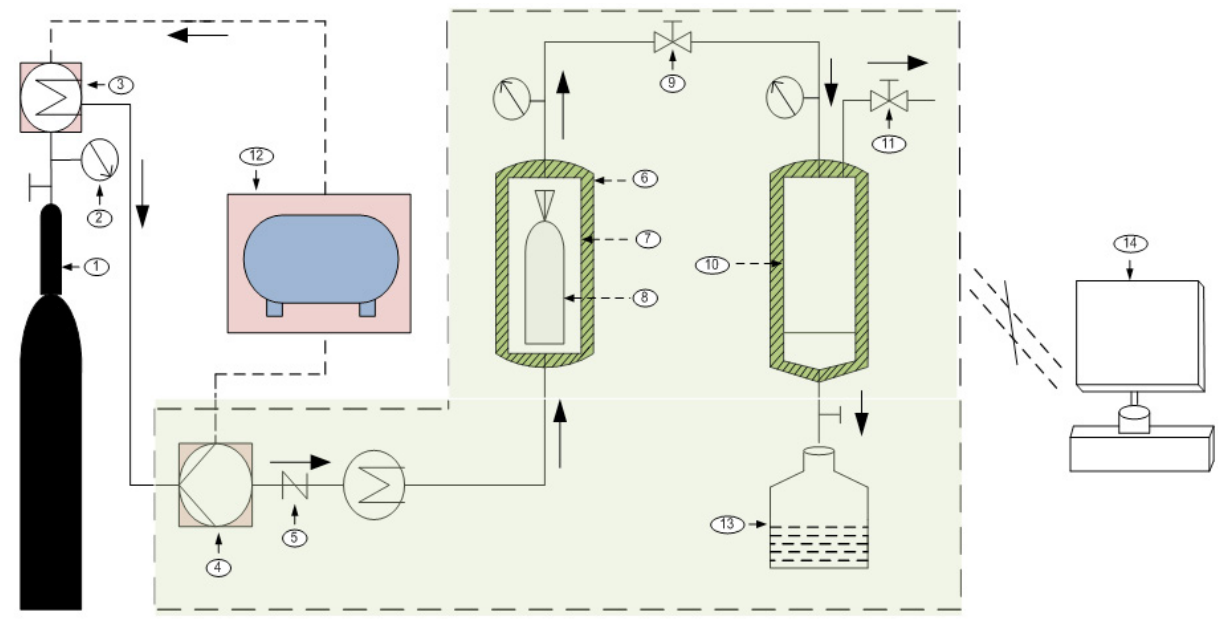
extraction unit controlled by automation program 2 pump, 5. Non-returning valve, 6. Cooling/Heating jacket, 7. Extractor, 8. Raw 2